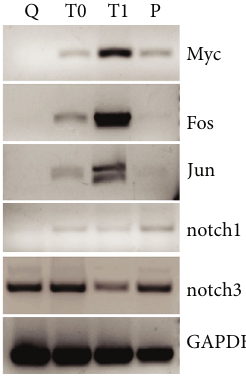
Figure 6: Dissociation of myospheres induces changes in the transcription pattern of the cells. Q: RNA extraction performed from mature myospheres; T0: cells processed for RNA extraction after myosphere dissociation was completed; T1: cells maintained in suspension in the culture medium at 37 ° C for 1 h after myosphere dissociation; P: cells from a